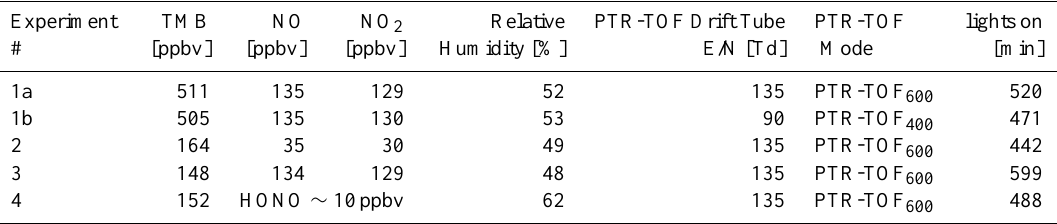
Figure 1. Schematic representation of the TMB oxidation pathways in the presence of NO x as implemented in the MCMv3.1 (first generation products only). 3 Table 1. Initial conditions of all conducted TMB experiments and PTR-TOF instrumental settings. Experimental conditions varied from about 150ppbv to 510ppbv TMB at VOC/NO x ratios between 0.5 and 2. During experiment 4, HONO was continuously added to the chamber to support OH